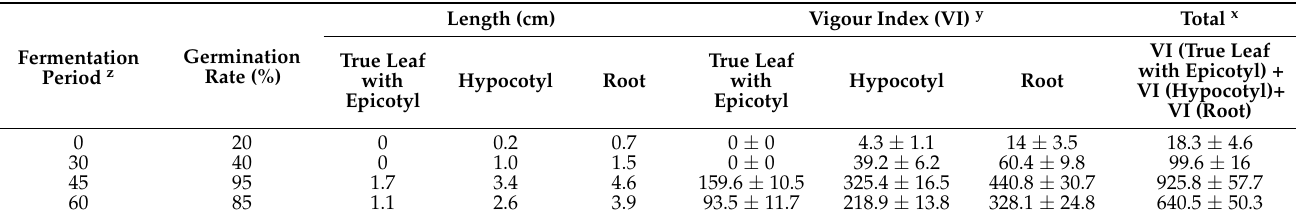
Table 1. Calculation of Vigor Index (VI) and total VI on seedlings each fermentation period of oak tree sawdust.